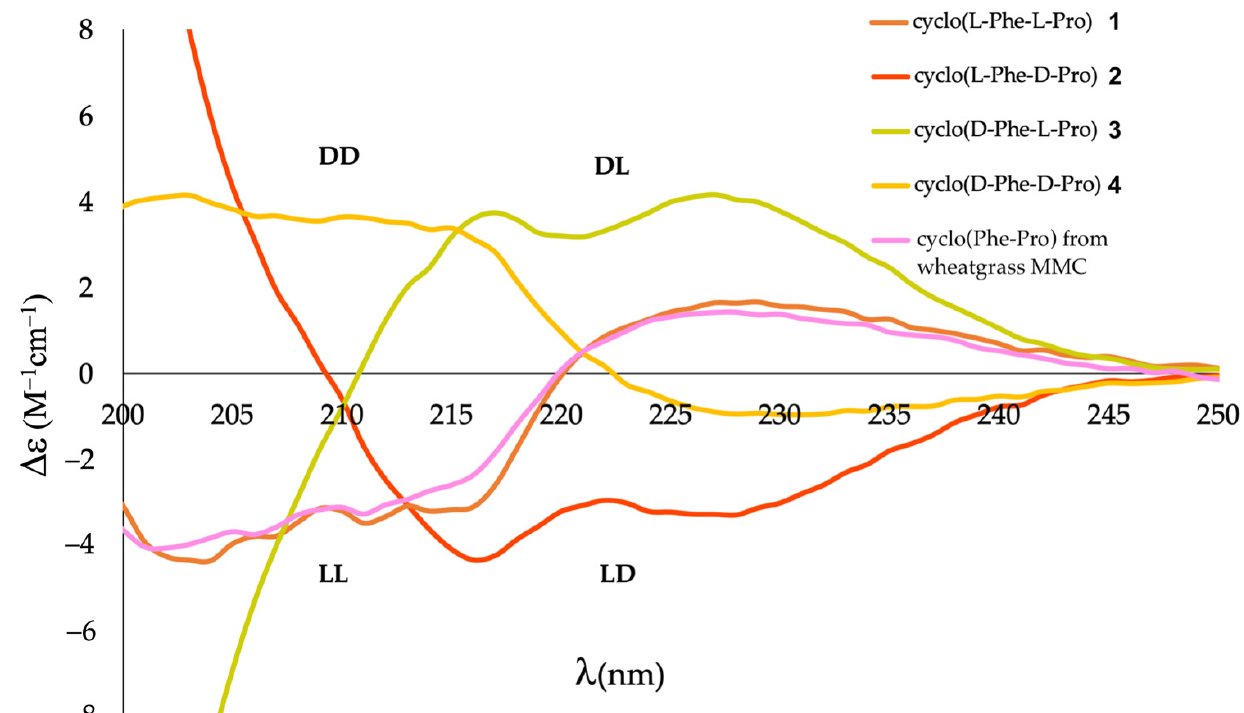
Figure 2. ECD spectra of synthetic cyclo(Phe-Pro) stereoisomers and a cyclo(Phe-Pro) sample with unknown stereochemistry from wheatgrass MMC (pink). Methanol (spectroscopic grade) was used as the solvent.